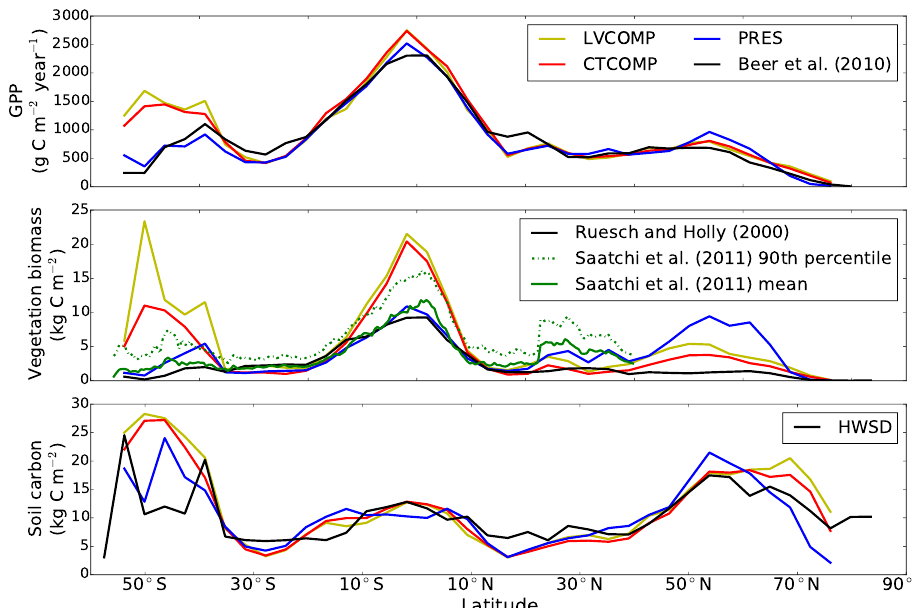
Figure 6. Zonal mean GPP (top), vegetation biomass (middle) and soil carbon (bottom) for CTEM simulations using (i) prescribed PFT fractional cover from the modified Wang et al. (2006) data set (PRES), (ii) the CTEM competition scheme, which uses modified L–V equations (CTCOMP) and (iii) simulations that use unmodified L–V equations (LVCOMP) compared to observation-based estimates. The observation-based estimate for soil carbon is based on the Harmonized World Soils Database (HWSD) version 1.2 (FAO/IIASA/ISRIC/ISS- CAS/JRC,